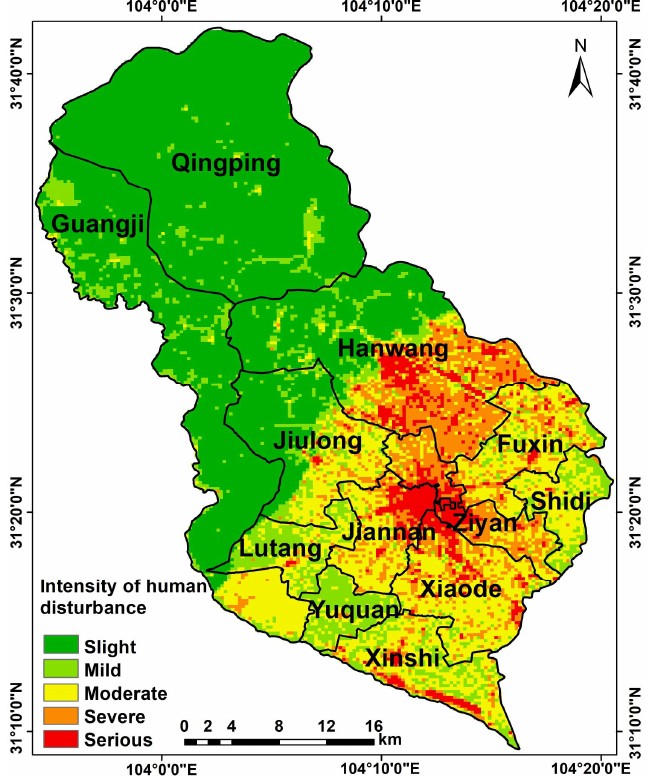
Figure 4. Human activity disturbance intensity.